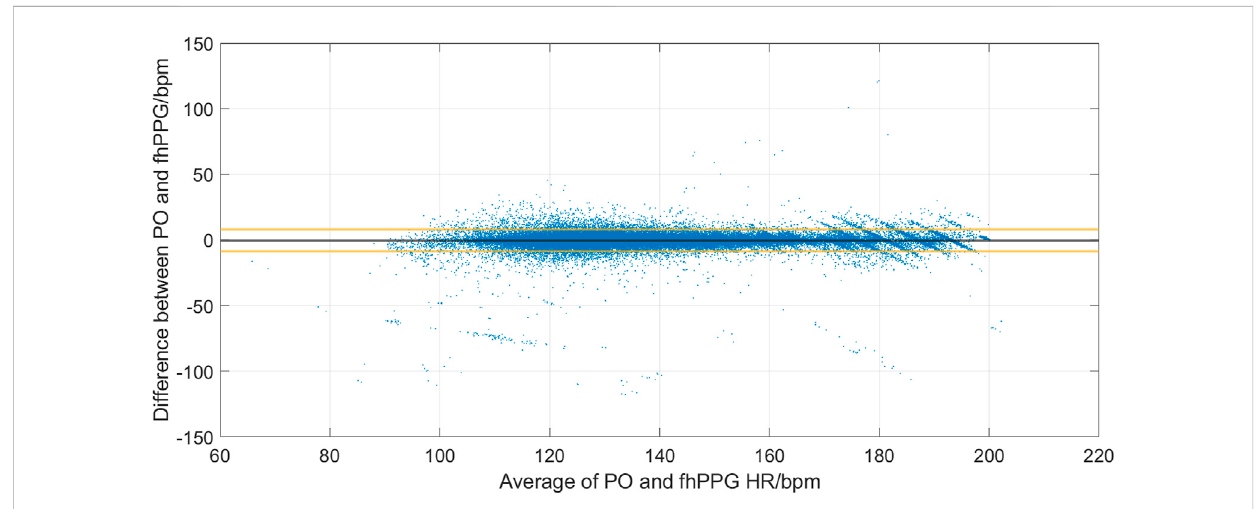
FIGURE 4 Bland-Altman analysis of PO and fhPPG (n = 142,567) for 19 subjects.